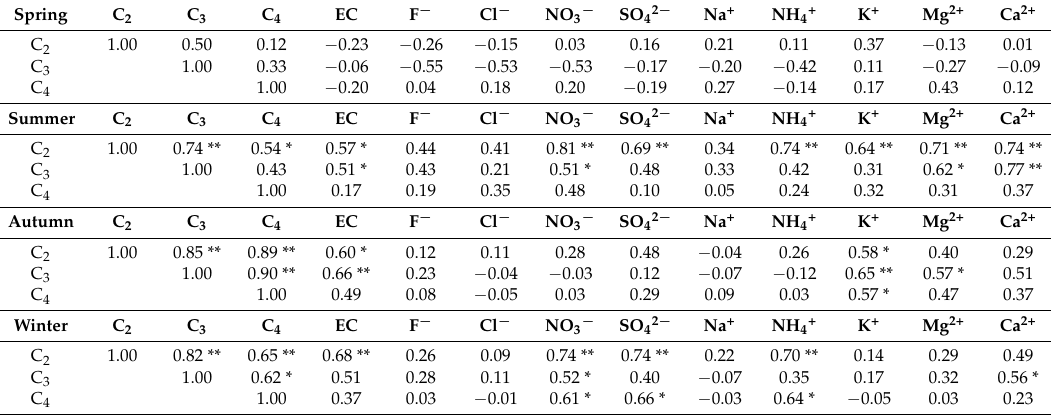
Table 2. Correlation ( r ) analysis among diacids, elemental carbon (EC), and water-soluble inorganic ions in the PM 10 aerosols in Huangshi, Central